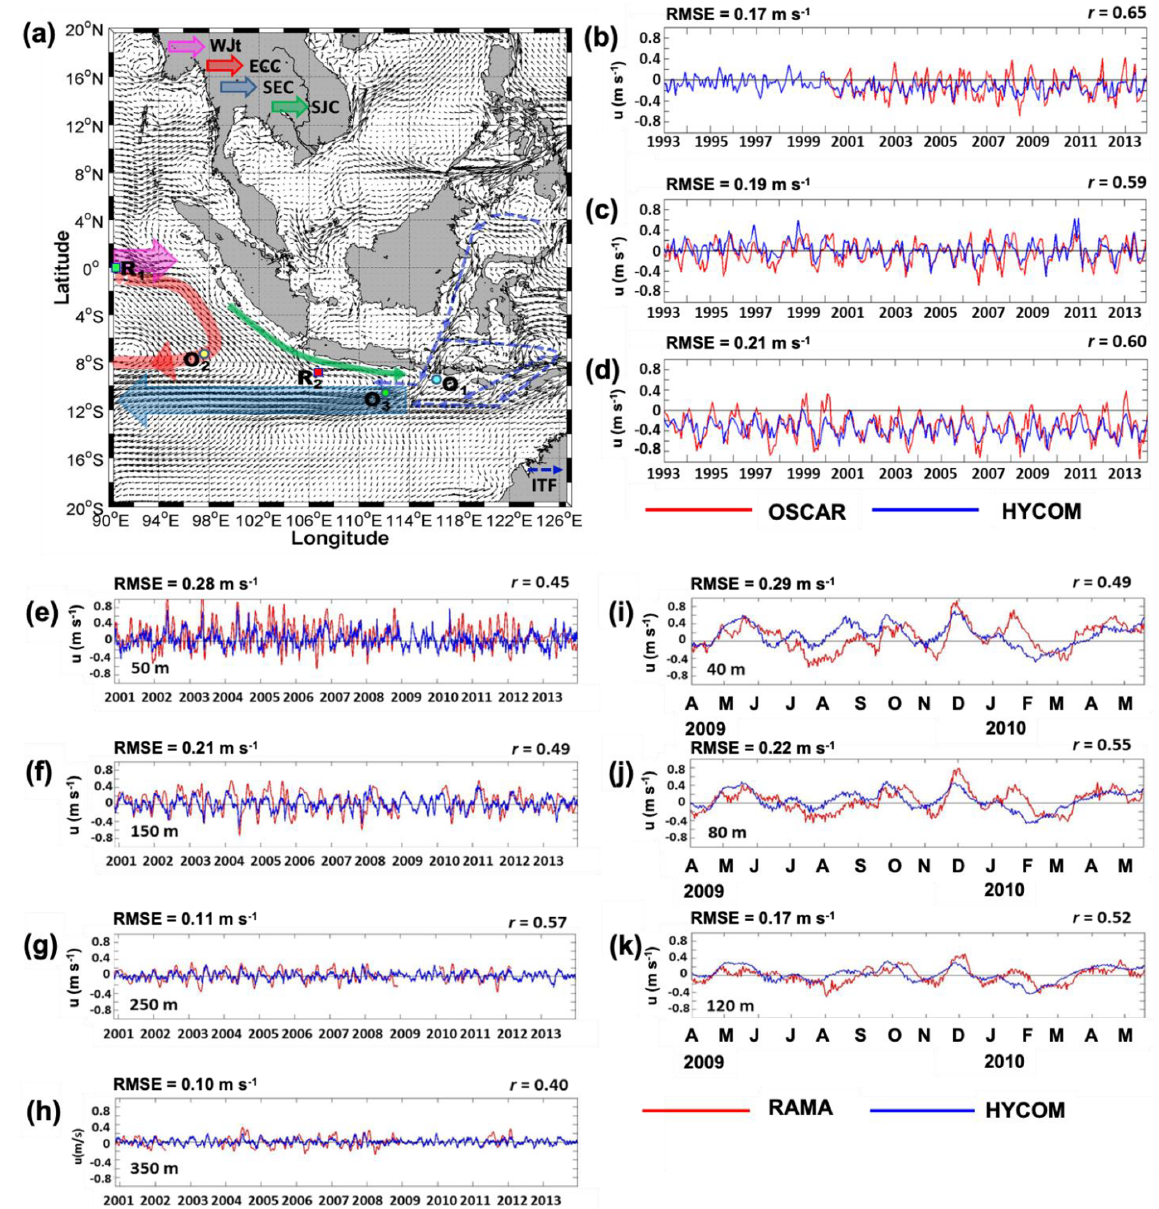
Figure 1. Validation of HYCOM zonal currents with OSCAR and RAMA datasets. (a) Locations of validation points are as follows: points O 1 (8 ◦ S, 116 ◦ E), O 2 (7 ◦ S, 98 ◦ E), and O 3 (11.5 ◦ S, 113 ◦ E) show the OSCAR data, while R 1 (0 ◦ S, 90 ◦ E) and R 2 (8.5 ◦ S, 106.75 ◦ E) show the RAMA data. (b–d) Time series of the zonal currents observed by the HYCOM (blue lines) and the OSCAR (red lines) at a depth of 0.5m at points O 1 , O 2 , and O 3 , respectively. Meanwhile (e) – (h) are the time series of zonal currents observed by the HYCOM (blue lines) and the moored RAMA (red lines) at point R 1 sequentially at depths of 50, 150, 250, and 350m. Meanwhile, (i) – (k) are the same as (e) – (h) , except for being for point R 2 at depths of 40, 80, and 120m,. In (e) – (h) (point R 1 ), a monthly low-pass filter has been applied before plotting. RMSE stands for root-mean-square error, r shows the correlation